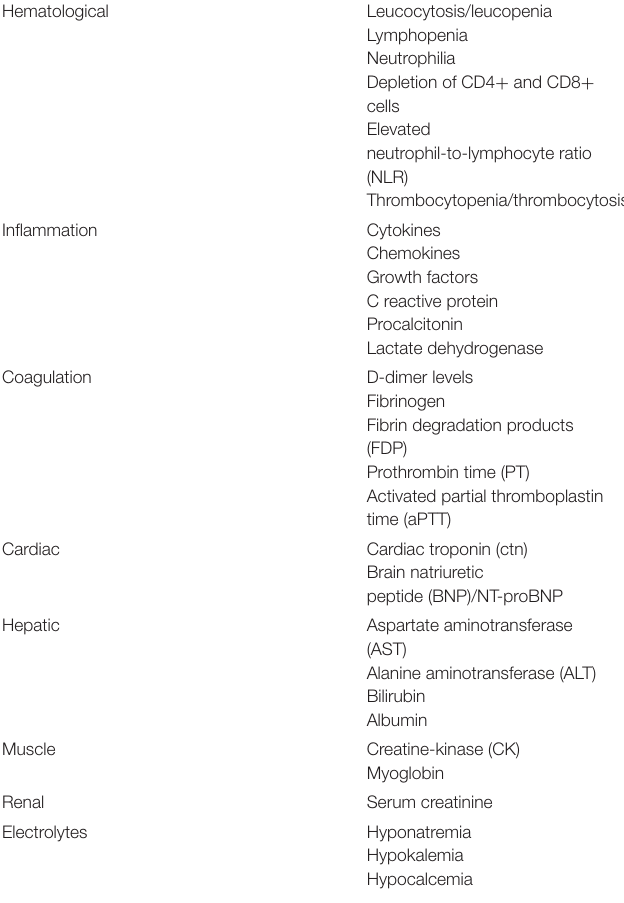
TABLE 1 | List of biomarkers in COVID-19 classified according to organ/system involved.